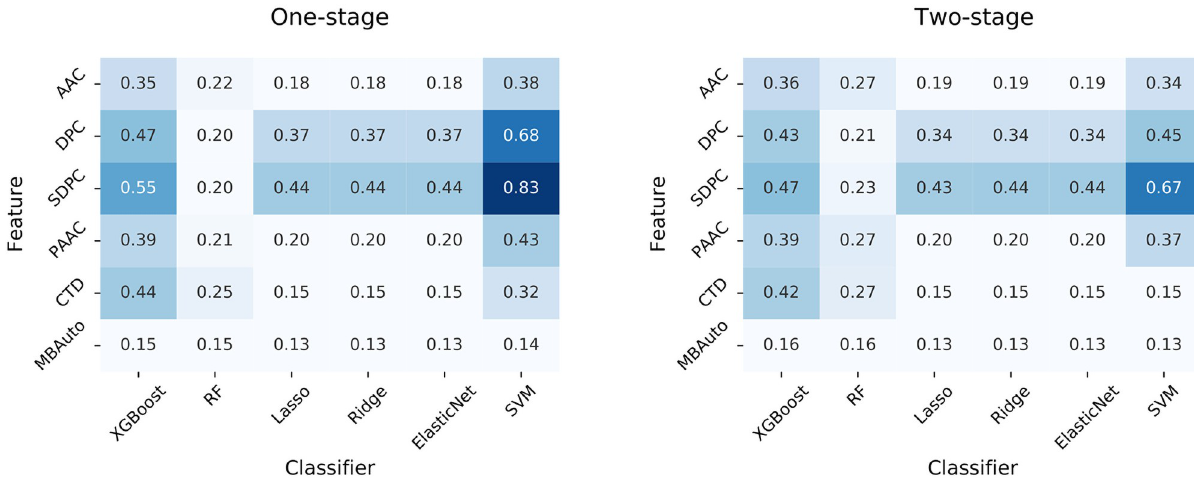
Fig 4. Heatmaps of the F1 scores obtained from baseline algorithms using 5-fold cross-validation. One-stage algorithms classify both non-HSPs and the six HSP families simultaneously. Two-stage algorithms use two models to filter out non-HSPs and classify the remaining HSPs into the six